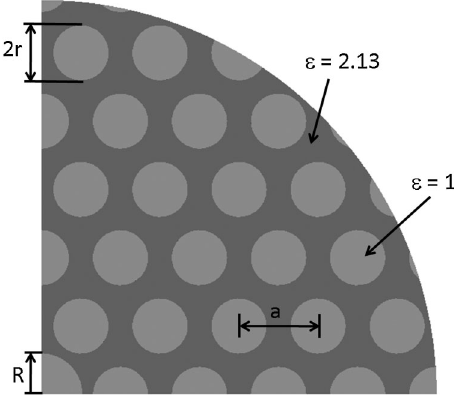
FIG. 1. Quarter cross section of the Lin PBG structure, con- sisting of a lattice of vacuum holes (white) in a glass substrate (gray) with lattice period a and hole radii r ¼ 0 : 35 a . The periodic lattice holes serve to confine the accelerating mode, and the particle beam is accelerated within the central defect, radius R ¼ 0 : 52 a , propagating perpendicular to the page.